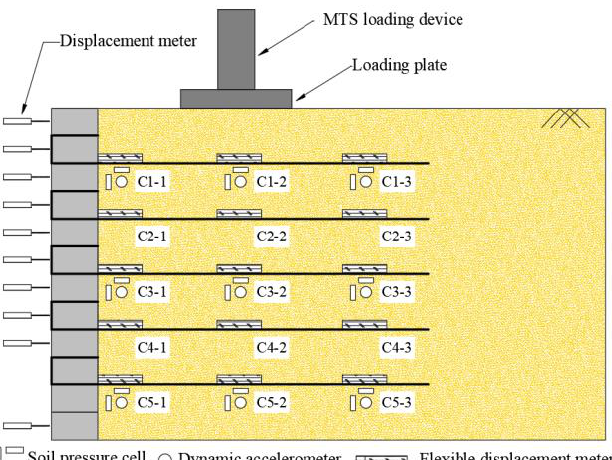
Figure 4. Instrument arrangement diagram.